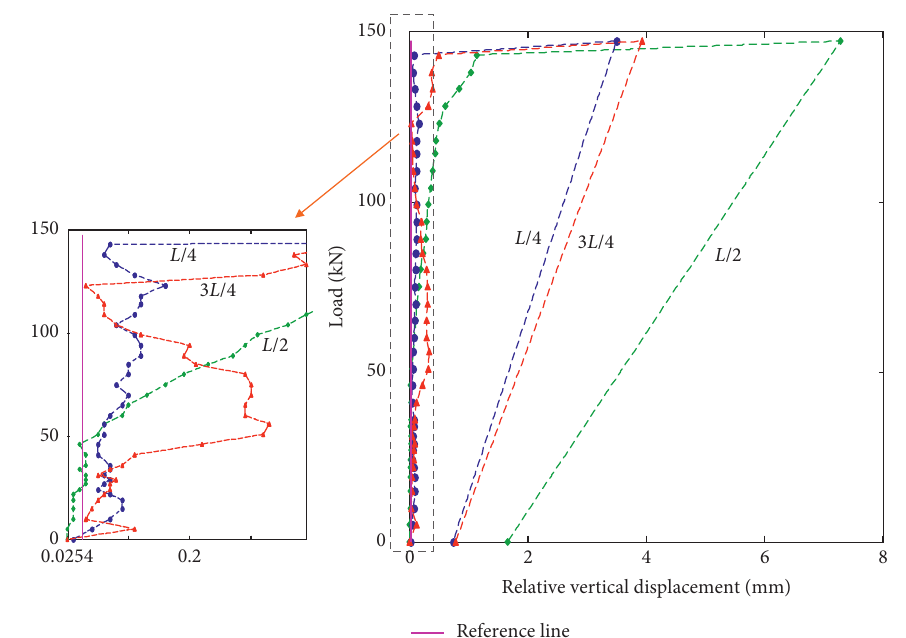
Figure 9: Relative vertical displacement at the edges of the two beams adjoining hinge joint #1.